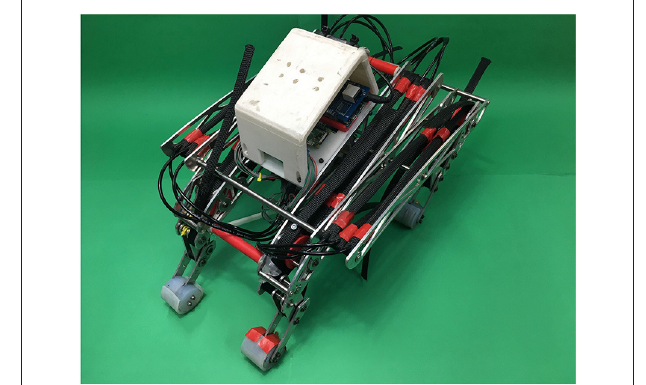
FIGURE 1 | Pneumatic quadruped robot “PneuHound.” The main objective of this robot is to perform dynamic turning by changing the phase difference among its legs.